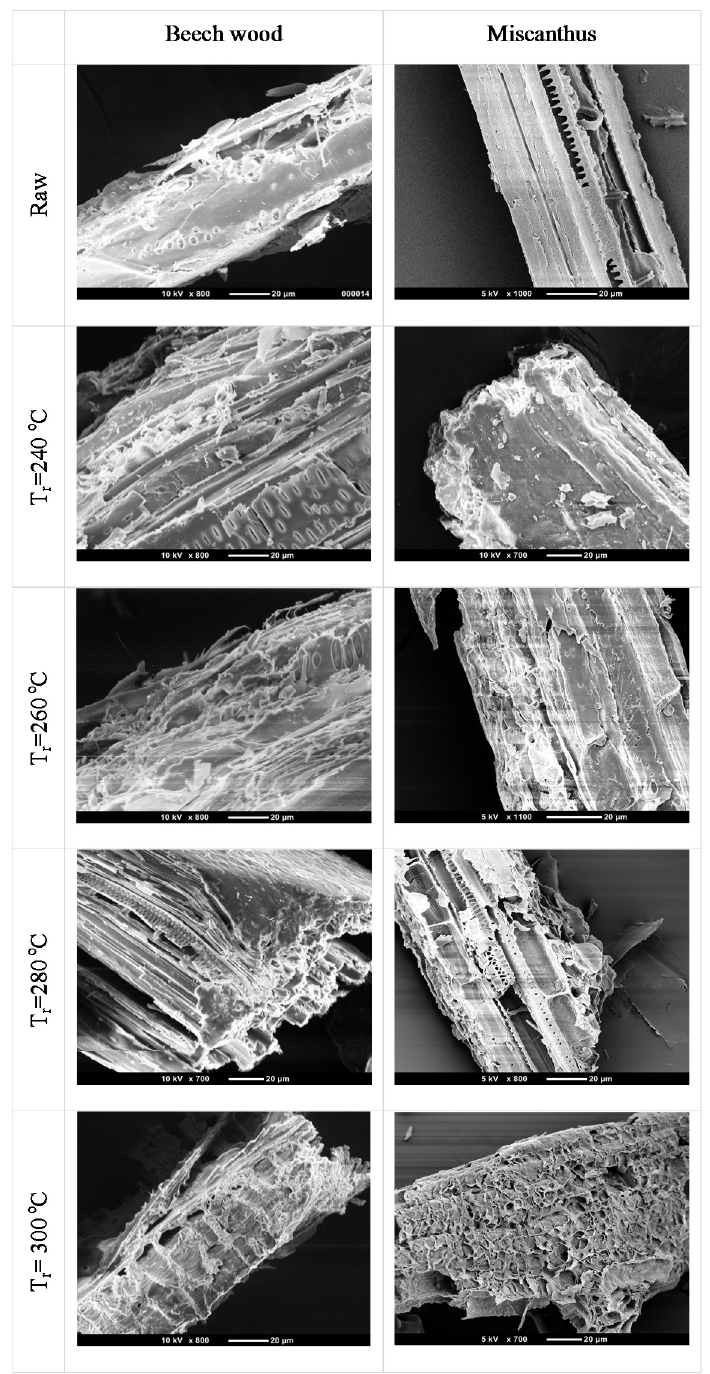
Figure 4. SEM images of raw and torrefied beech wood ( first column ), raw and torrefied miscanthus ( second column ) at various temperatures and a residence time of 30